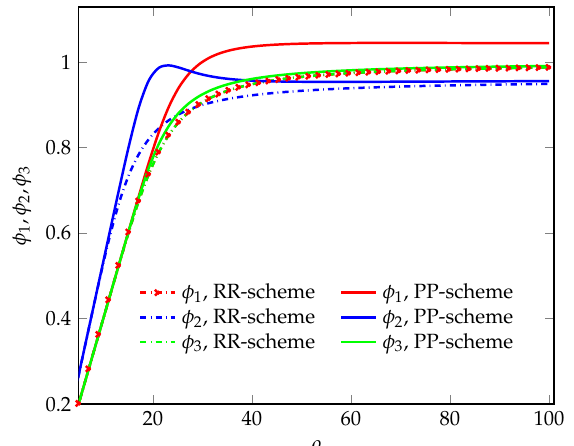
Figure 10. The average utilization of the guaranteed network capacities vs. the offered